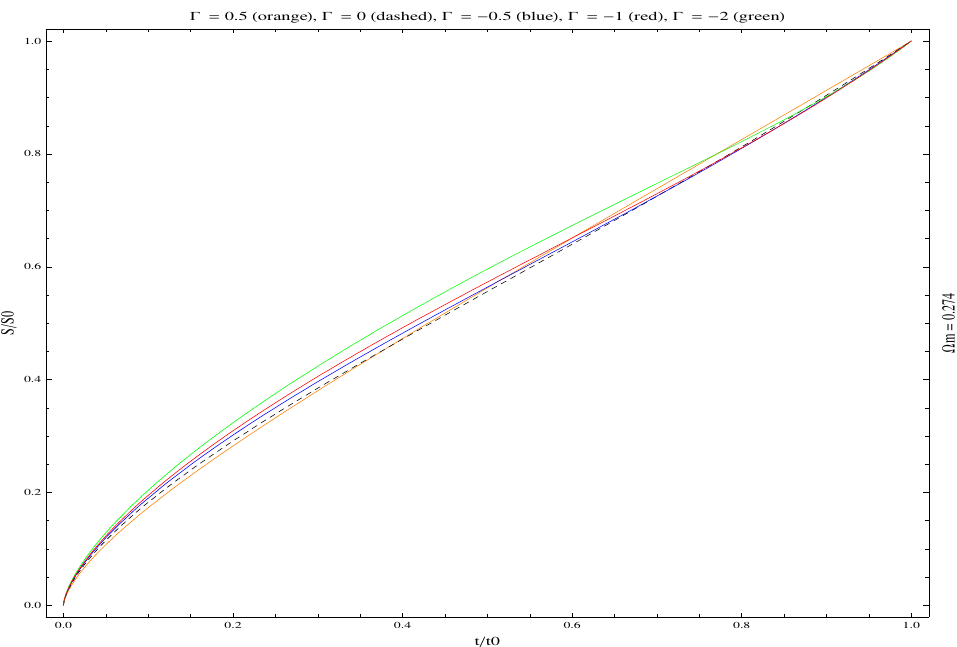
Figure 1. The scale factor, S , of the polytropic DM model in units of its present-time value, S 0 , as a function of cosmic time t (in units of t 0 ), for Γ = 0.5 (orange), Γ = 0 (dashed), Γ = − 0.5 (blue), Γ = − 1 (red), and Γ = − 2 (green). For each and every curve, there is a value of t < t S ( t ) becomes concave, i.e., the polytropic DM universe accelerates its